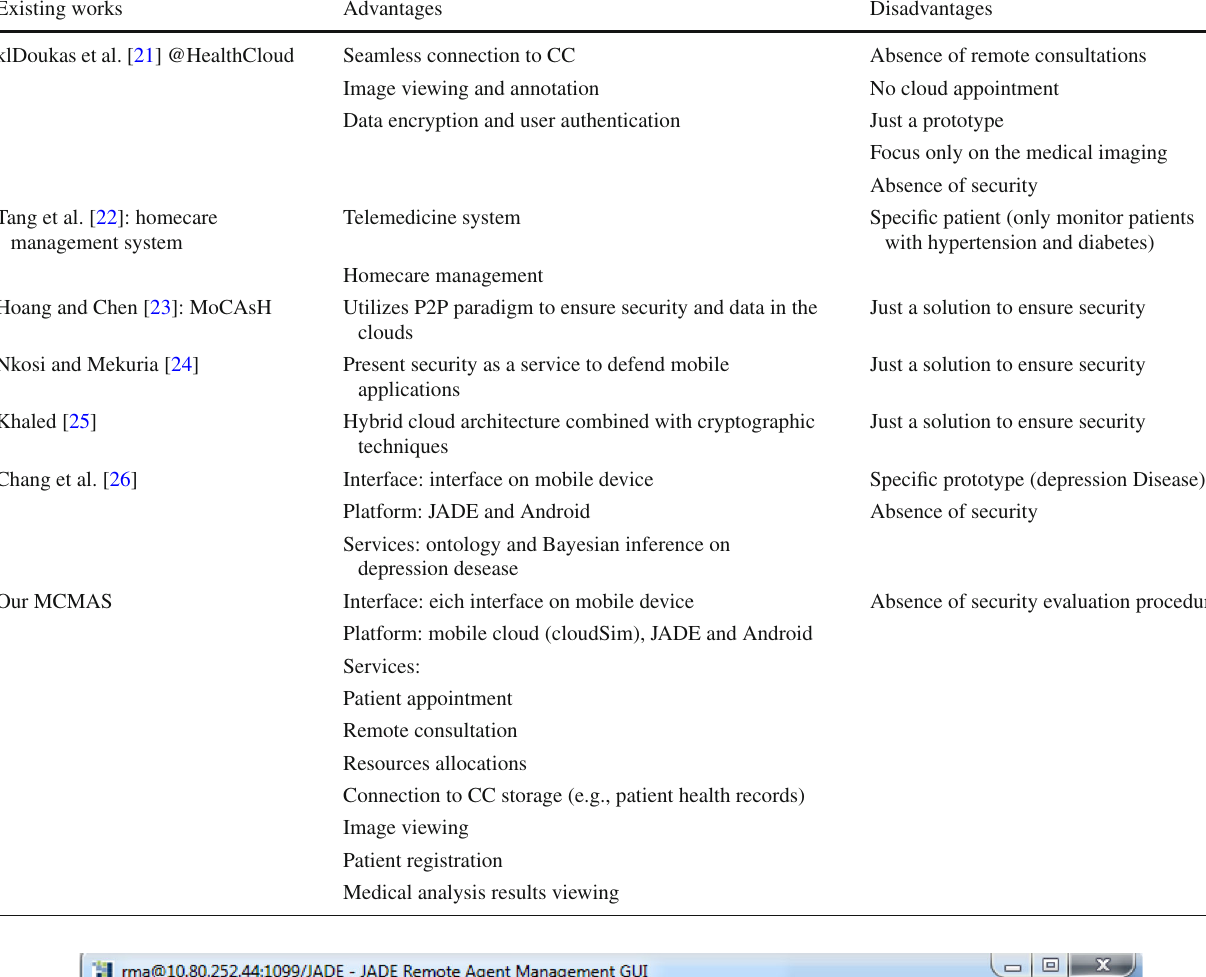
Table 1 Advantages and disadvantages of existing works in healthcare and the position of our system